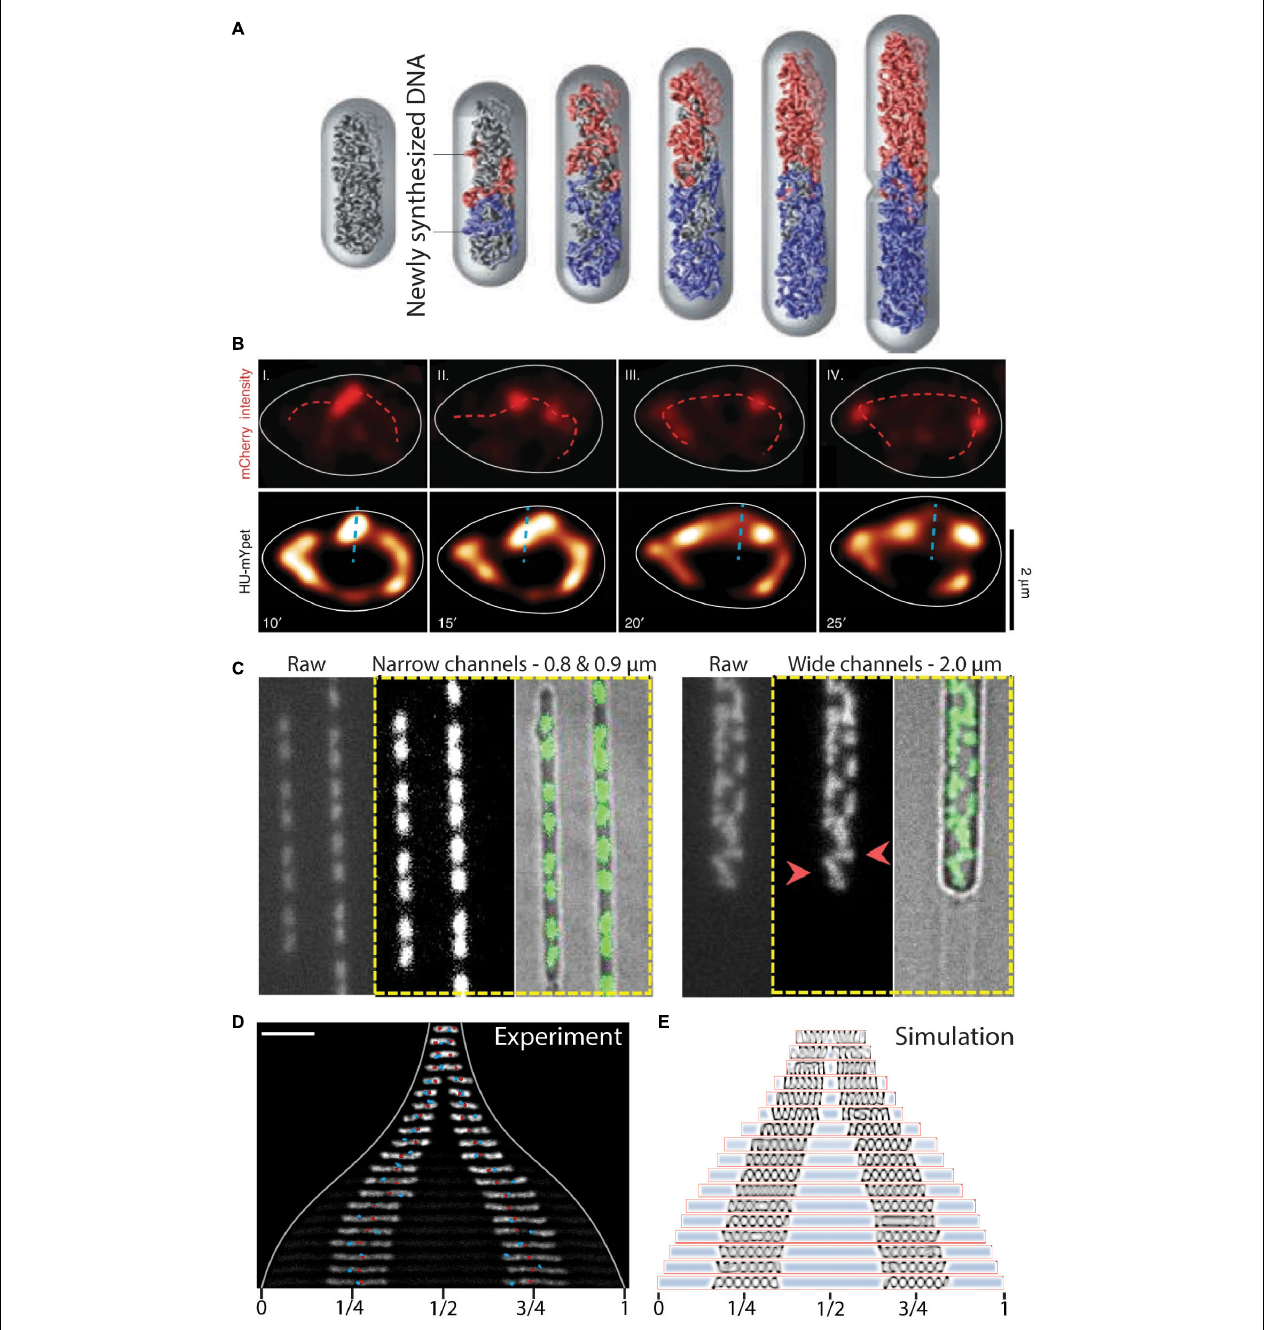
FIGURE 5 | The role of entropy in segregation of chromosomes. (A) Simulation of chromosome segregation during replication. Newly synthesized sister chromosomes (blue and red) spontaneously move toward the poles due to entropic forces between the polymers under the confinement of the cell wall. From Jun and Wrigth (2010). (B) Independently moving replisomes (labeled in red with mCherry, top row) in widened E. coli cells. Initial segregation of the chromosome (labeled in yellow with HU-mYpet, bottom row) is along the short axis of the cell (dashed blue line), indicating a disturbed early ori segregation due to the loss of cell wall confinement on the replicating chromosomes. Time is indicated in minutes. From Japaridze et al. (2020). (C) L-form B. subtilis cells in microfluidic channels of varying width. Polar segregation of replicating chromosomes is maintained in narrow channels (0.8–0.9 µ m), whereas replicated chromosomes are more randomly distributed in the cells in wider channels (2.0 µ m). Red arrowheads point at examples of orthogonally and perpendicularly oriented nucleoids relative to the cellular long axis. From Wu et al. (2020). (D) Re-distribution of two chromosomes in an elongated E. coli cell . The chromosomes increase in size and spontaneously localize at 1/4 and 3/4 positions along the cell length. Ori and ter sites are visualized as red and blue foci, respectively. Scale bar 5 µ m. From Wu et al. (2019b). (E) Molecular dynamics simulations capture the size and positioning of two chromosomes over the cellular space as a consequence of cytosolic molecular crowding and the entropic spring-like nature of the nucleoids. From Wu et al.